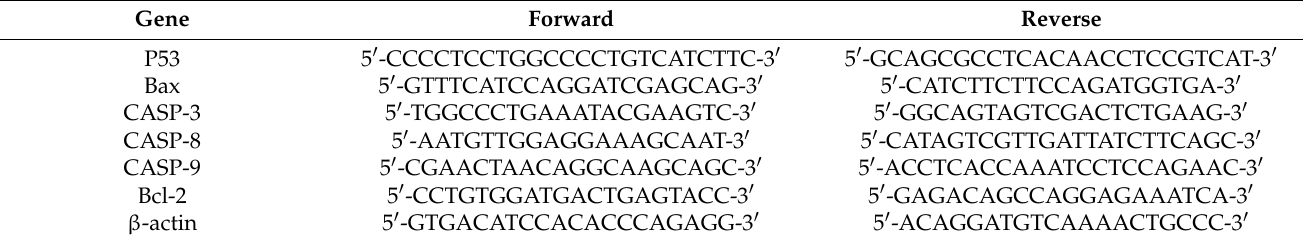
Table 5. Sequences of forward and reverse